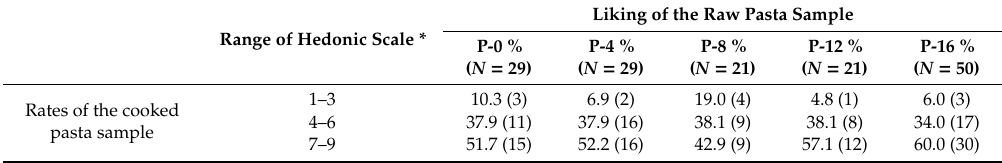
Table 3. Distribution of liking scores of the cooked pasta sample with regards to the liking of the raw pasta sample. Liking of the Raw Pasta Sample Range of Hedonic Scale * P-0 % ( N = 29) 1–3 Rates of the cooked pasta sample